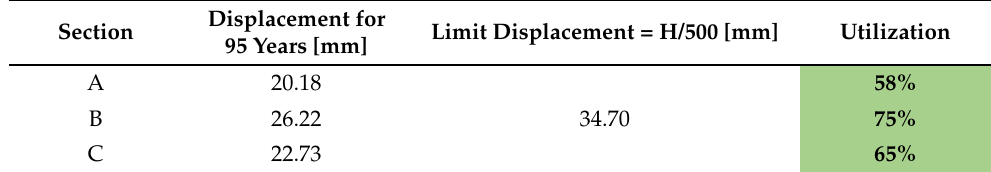
Table 5. Validation of global displacements (EN 1990).